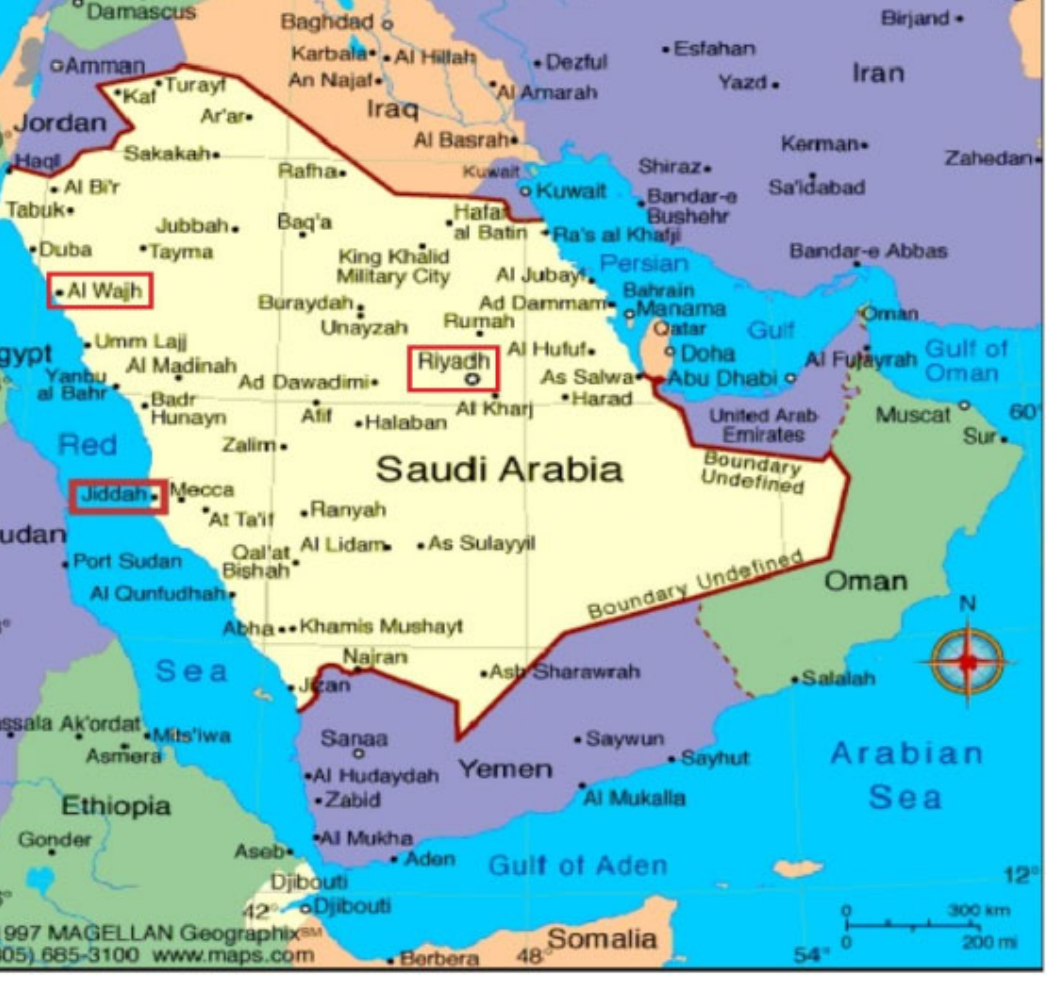
Figure 1. Map of Saudi Arabia, with red boxes pointing to the locations where camel milk samples were collected from private farms.